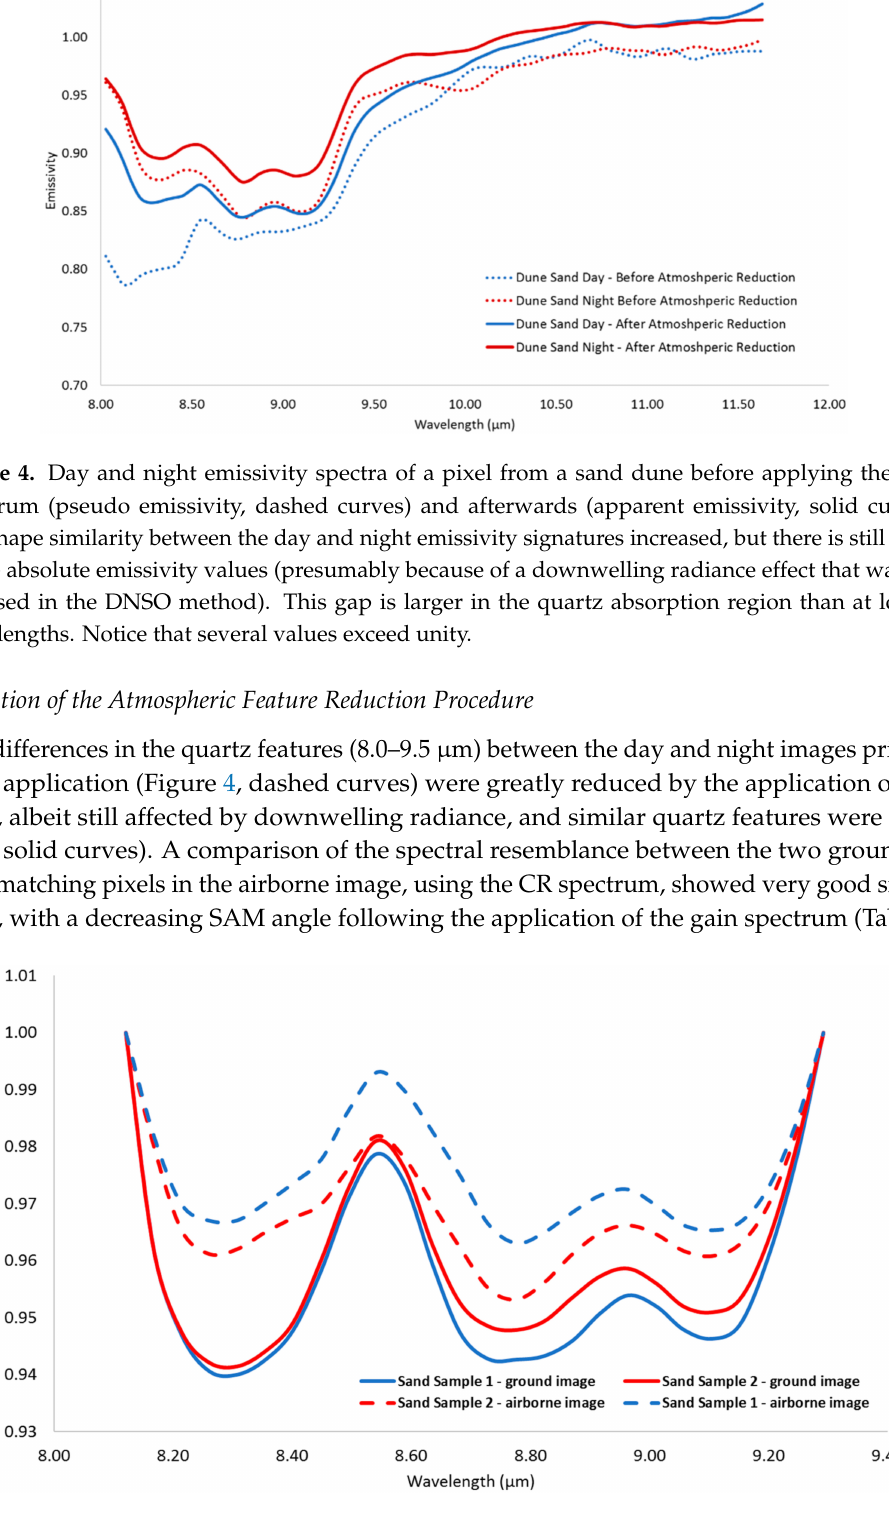
Figure 5. Comparison of the quartz emissivity feature ( CR values 8.12 < λ < 9.29) in the ground image and airborne image pixels. The same features are noticeable in the spectra after applying the gain spectrum calculated from the algorithm’s